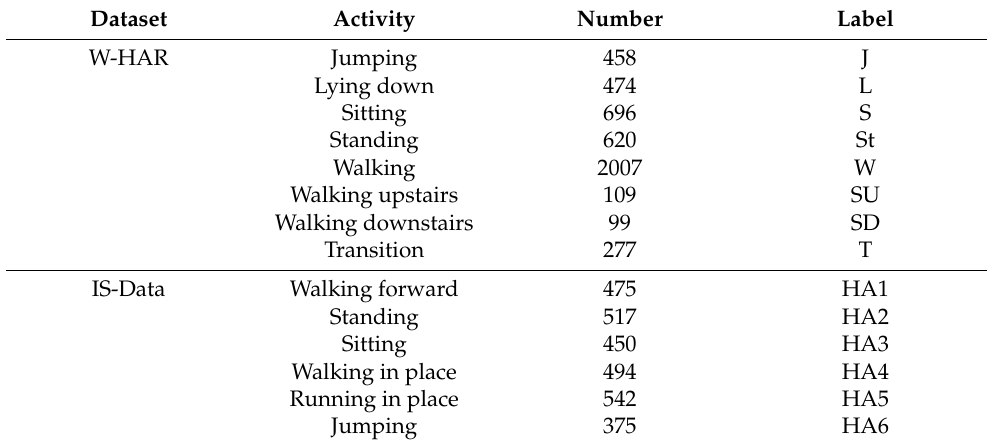
Table 1. Dataset activity lists.